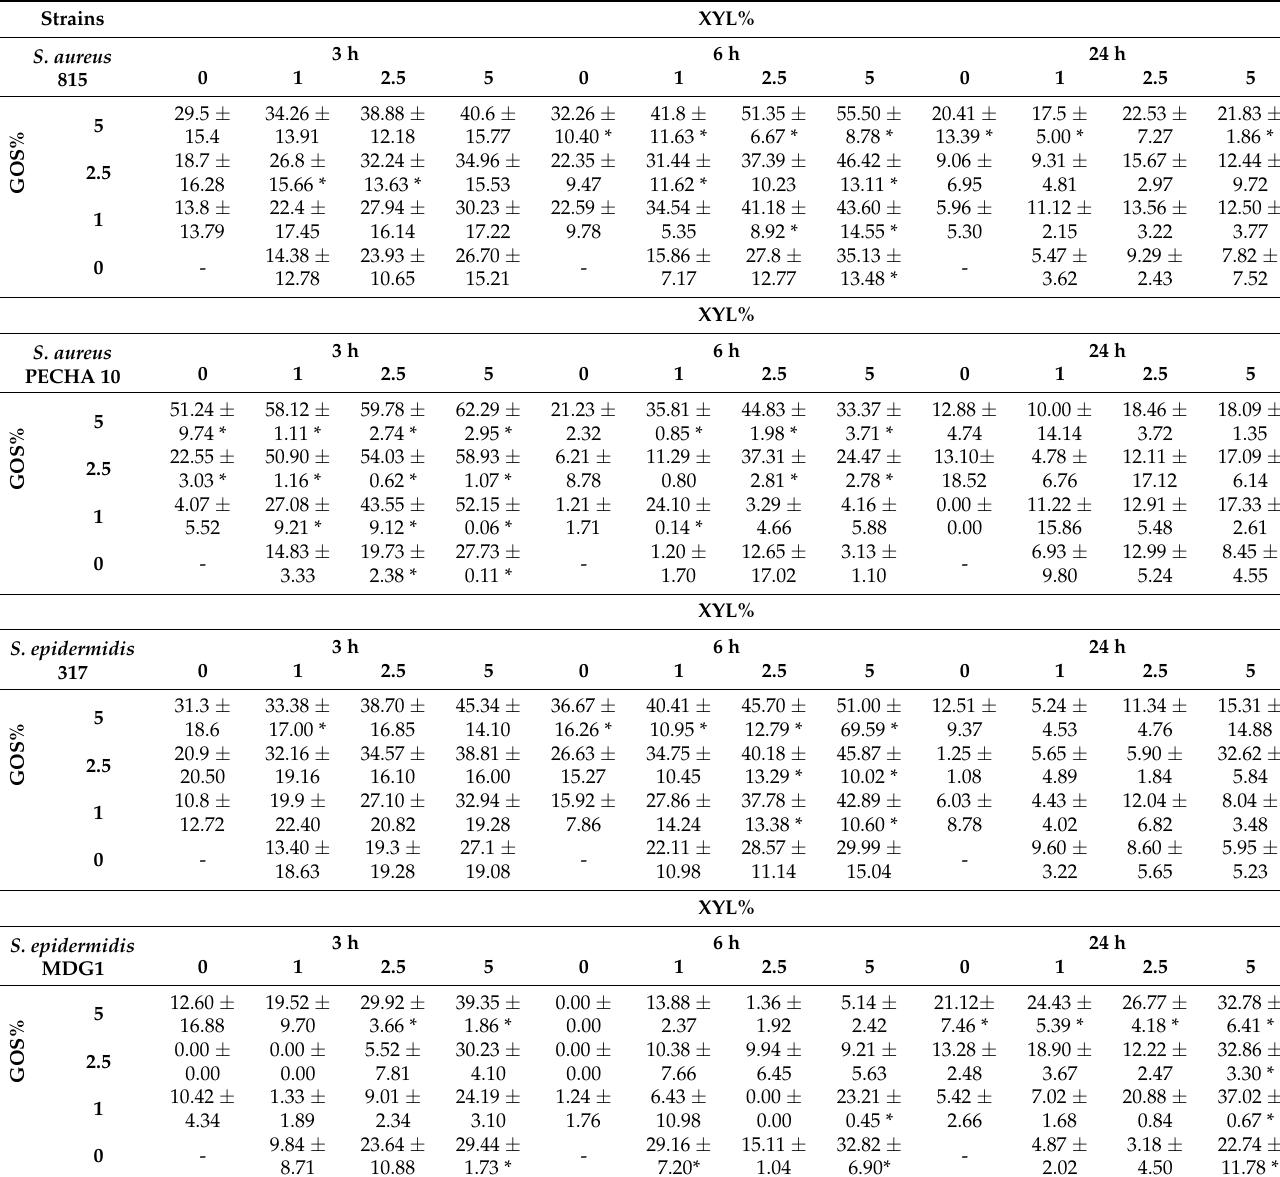
Table 1. Percentages of planktonic S. aureus 815, S. aureus PECHA 10, S. epidermidis 317 and S. epidermidis MDG1 growth reduction (OD 600 ) after 3, 6, 24 h of contact with Xylitol (XYL) and Galacto-OligoSaccharide (GOS) at different concentrations (1, 2.5,